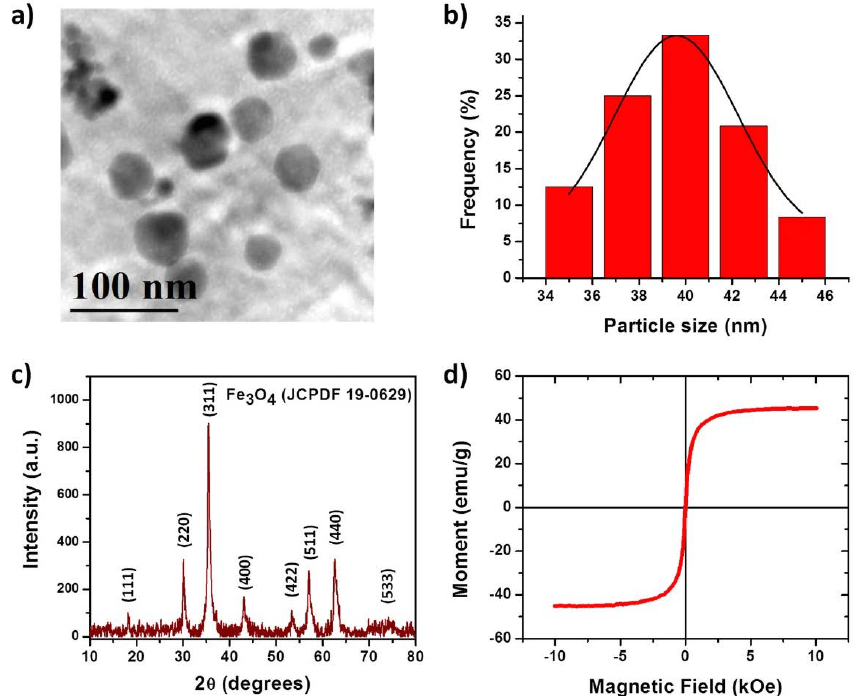
Figure 3. ( a ) TEM micrograph of iron oxide nanoparticles (IONPs) (Fe3O4 NPs), ( b ) particle size distribution determined by dynamic light scattering (DLS), ( c ) X-Ray diffraction pattern, and ( d ) hysteresis loop of IONPs at 298 K.